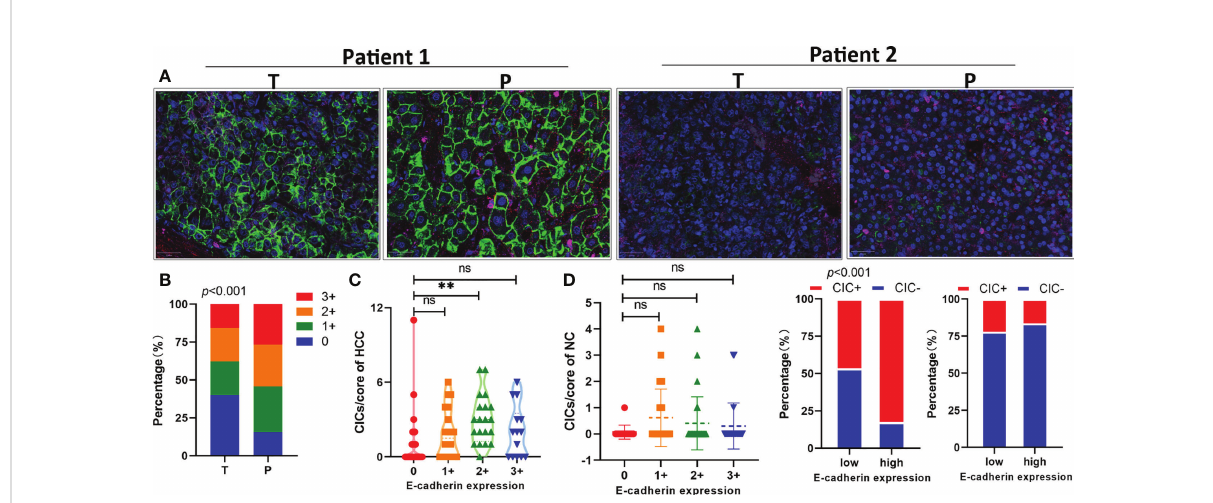
FIGURE 3 E-cadherin expression in tumor tissues is positively associated with homotypic CIC formation. (A) Representative images for high (two on the left) or low (two on the right) levels of E-cadherin expression in pair-matched tumor (T) and para-tumor (P) tissue samples of the TMA by immuno fl uorescent staining. The TMA slides were stained with antibodies against E-cadherin (green), CD44 (red), CD45 (pink), and DAPI staining of the nucleus (blue). (B) Quanti fi cation of E-cadherin expression in pair-matched tumor (T) and para-tumor (P) tissue samples of the TMA. n = 180 with 90 for tumor and 90 for para-tumor, respectively. (C) E-cadherin expression correlated signi fi cantly with CIC formation in tumor tissues (left), but not in para-tumor tissues of the TMA. (D) CIC compositions in low or high E-cadherin expression groups of tumor (left) and para-tumor tissues (right). *P < 0.05; **P < 0.01; ***P < 0.001; ns, not signi fi cant.